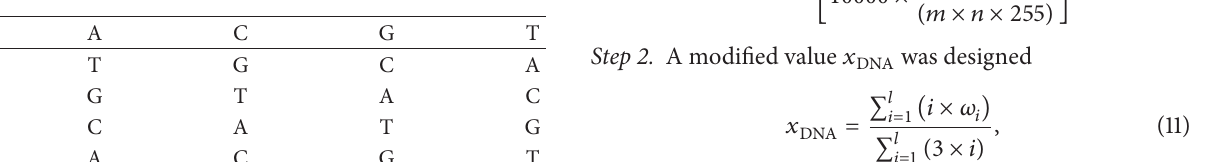
Table 2: Multiplication operation of DNA sequence.